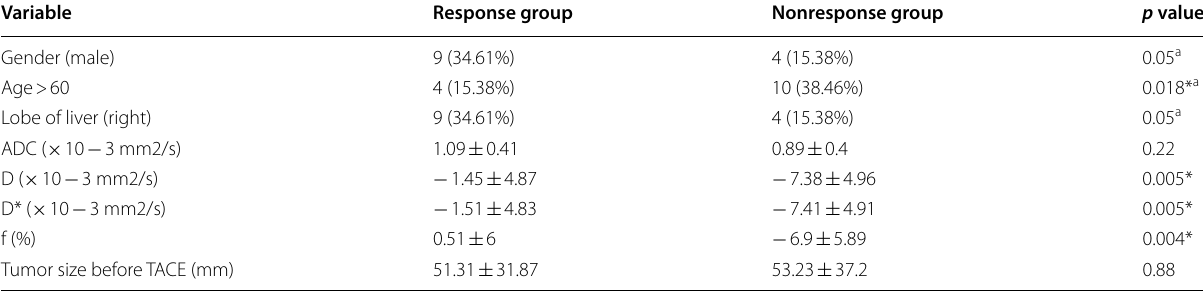
All quantitative data are expressed as mean